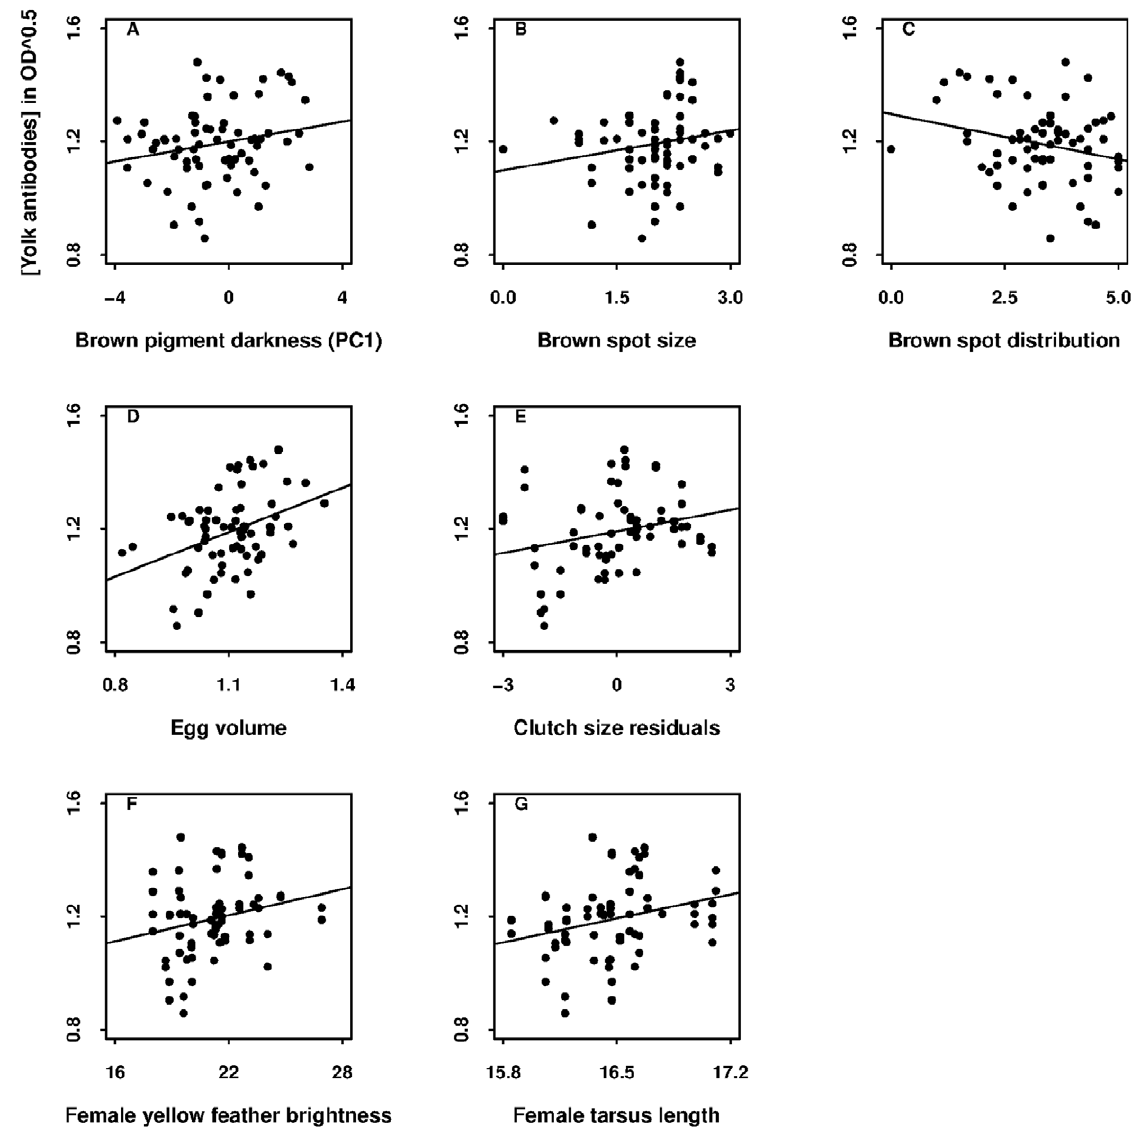
Figure 3. The significant predictors of yolk antibody concentration in OD 0.5 in blue tit eggs. They were (A) brown pigment darkness (PC1), (B) brown spot size and (C) distribution of eggshells, (D) egg volume, (E) residuals of clutch size on laying date, (F) yellow feather brightness, and (G) tarsus length of females. Plots show the data used in the egg- and female-trait model (Table 2).